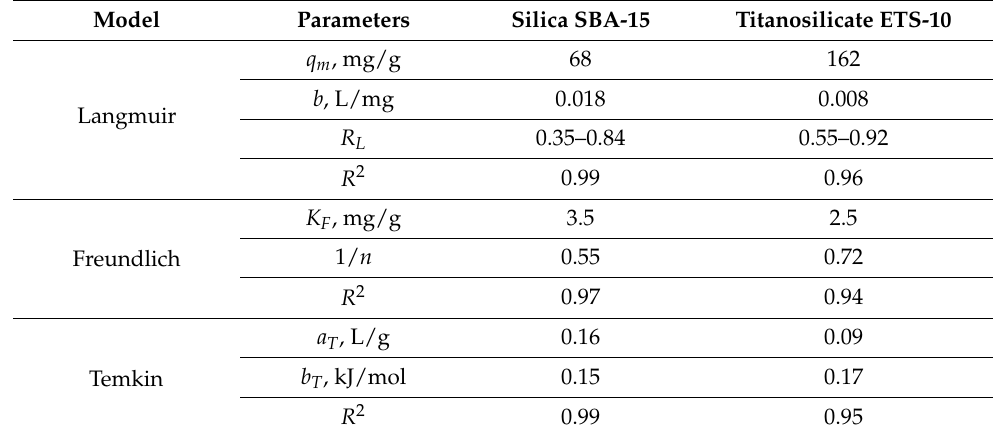
Table 1. Equilibrium isotherms parameters for the sorption of Ce(III) on silica SBA-15 and titanosili- cate ETS-10 sorbents. Model Parameters Silica